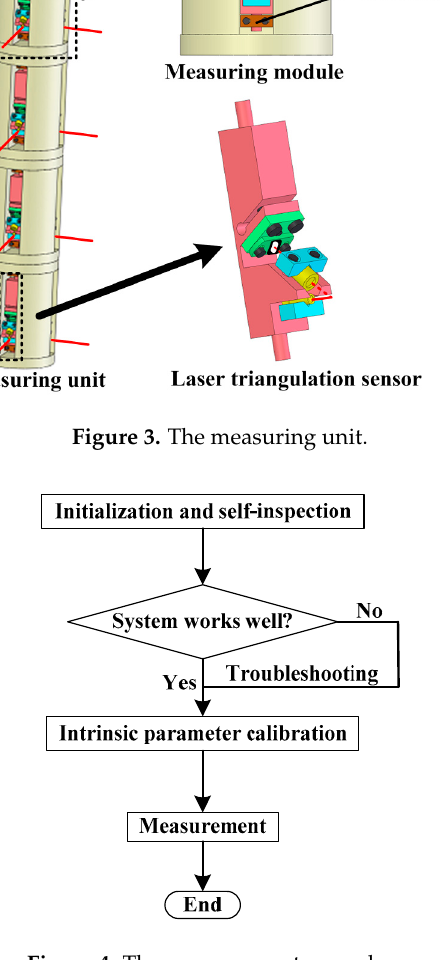
Figure 4. The measurement procedure.